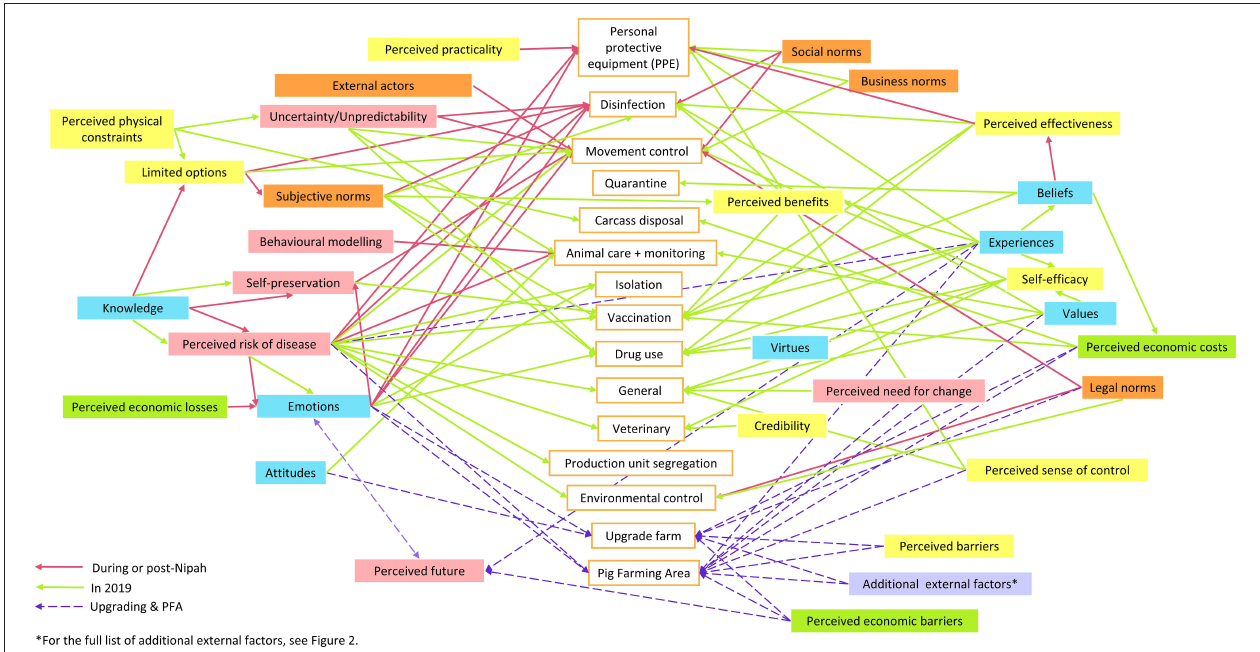
FIGURE 1 | Conceptual map of 12 male Malaysian pig farmers’ (10 small-medium scale farms, 2 large scale farms) mental model demonstrating relationships between dimensions and specific disease prevention and control practices. The pink arrows represent dimensions associated with practices during or post 1998 Nipah virus outbreak (practice decisions made immediately after Nipah or because of Nipah), green arrows represent dimensions associated with practices in 2019 (farmers did not expressed that practices were influenced directly by Nipah), and purple dotted arrows represent dimensions related to upgrading of farm biosecurity and/or adopt closed-house system and decision to move to Pig Farming Areas (PFAs). For example, perceived economic barriers directly influenced upgrading of farm and the decision to move to PFAs in some farmers while other farmers thought that perceived economic barriers impacted their perceived future and emotions, which subsequently influenced upgrading of farm and the decision to support